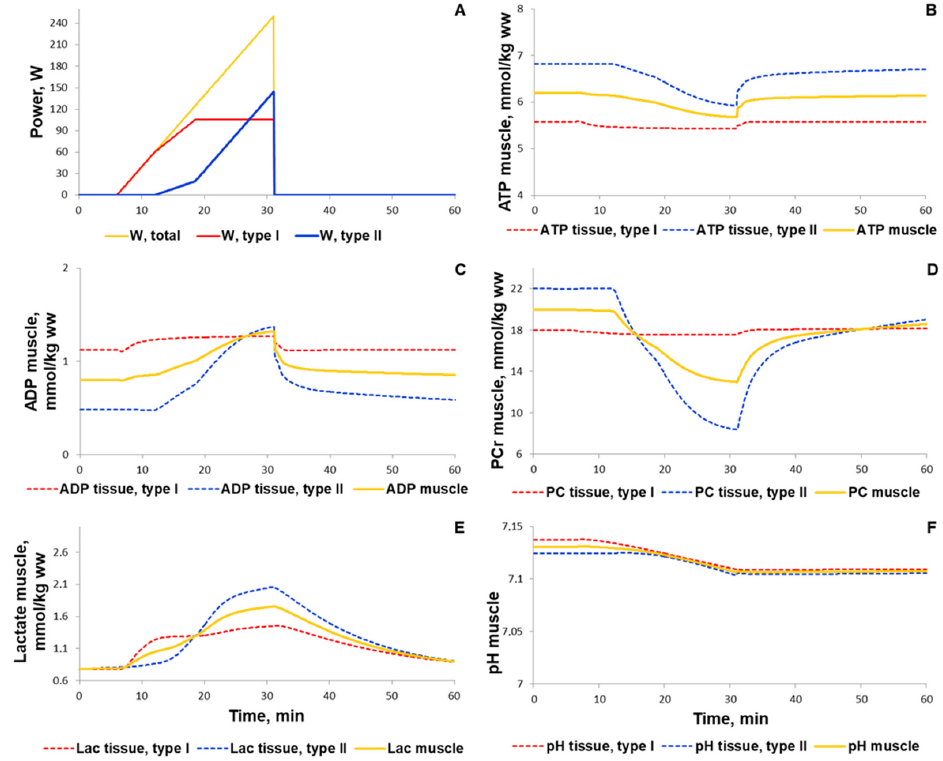
Figure 8. Simulation results for the incremental ramp exercise until exhaustion. ( A ) Exercise power and fiber recruitment pattern: total power (orange), power generated by type I (red) and II (blue) fibers; ( B – D ) ATP, ADP, and PCr concentrations in type I (red, dotted) and II (blue, dotted) fibers and in the muscle tissue (orange, solid); ( E , F ) Lactate concentrations and pH changes in type I (red, dotted) and II (blue, dotted) fibers and in the muscle tissue (orange, solid).